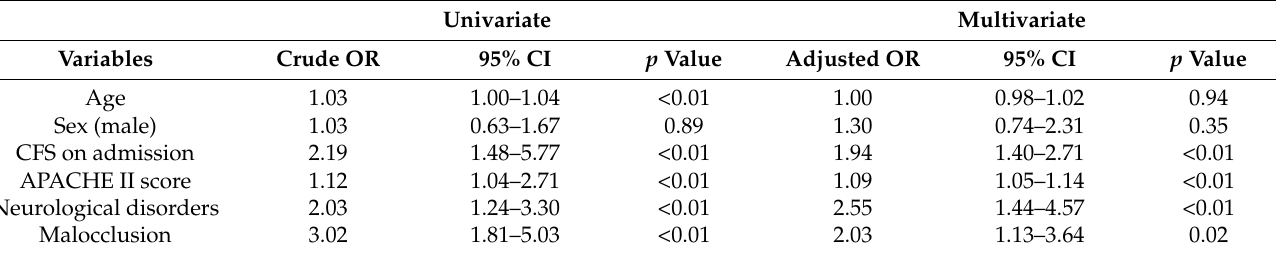
Table 3. Univariate and multivariate analyses for ADL loss of the study